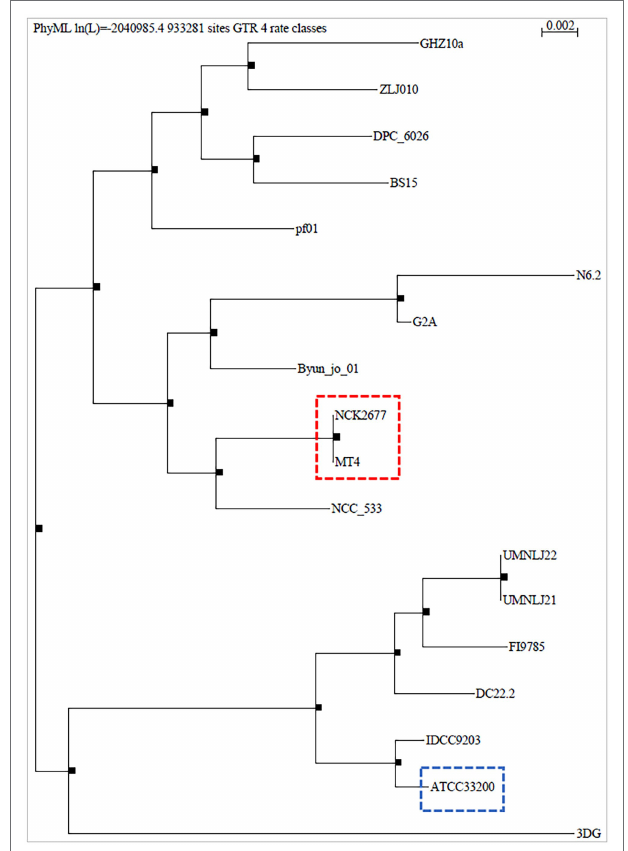
FIGURE 1 | Phylogenetic analysis of Lactobacillus johnsonii MT4. The whole genome of the L. johnsonii MT4 strain was analyzed to assess its phylogeny. The phylogenetic analysis of the MT4 strain shows the relation of our strains with other 17 L. johnsonii strains (genomes from the NCBI database). The analyzed L. johnsonii strains are NCK2677, ATCC 33200, N6.2, 3DG, BS15, Byun_jo_01, DC22.2, DPC_6026, FI9785, G2A, GHZ10a, IDCC9203, NCC_533, UMNLJ21, UMNLJ22, ZLJ010, and pf01. All branch support values are 1. The phylogenetic analysis shows that MT4 and NCK2677 share >99.96% of identity (red square). The closest relative to strain MT4/NCK2677 is NCC_533 (La1). ATCC 33200 strain (blue square) was used for some experiments as a